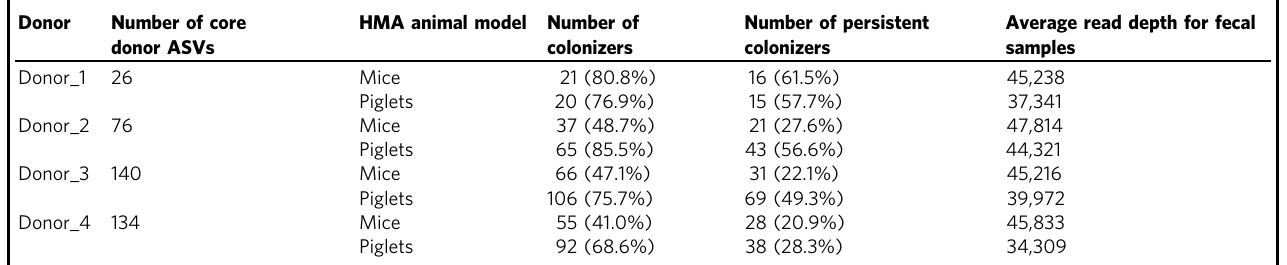
Table 1 Summary of the establishment of core donor ASVs in the two HMA animal models for each donor.